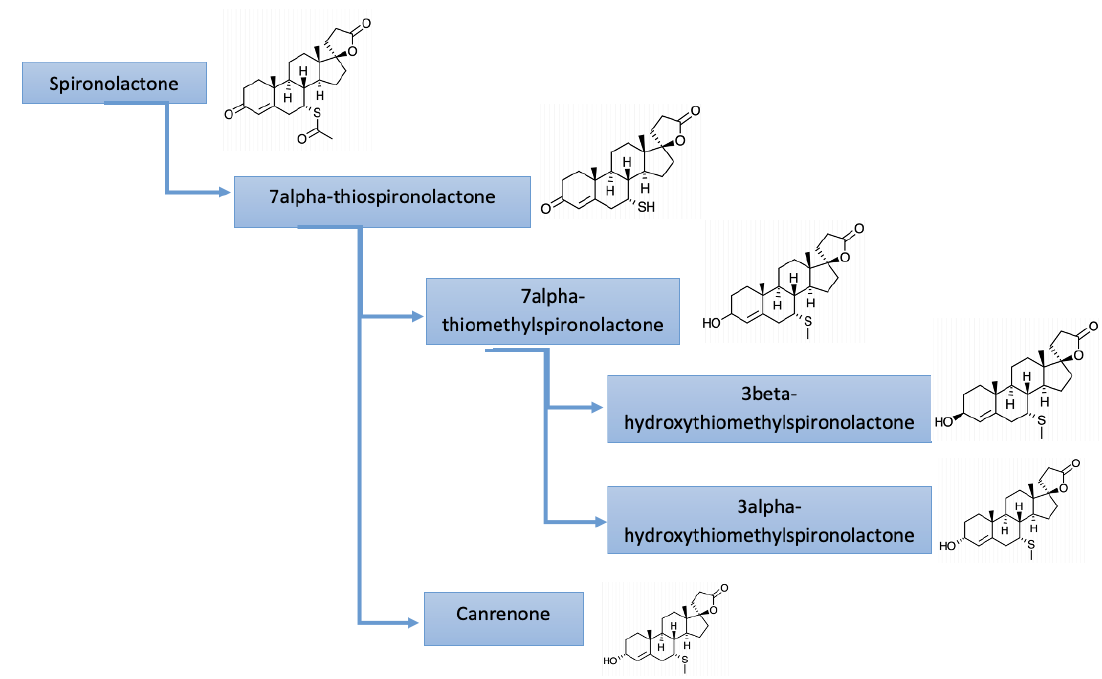
Figure 1. Metabolites of spironolactone.